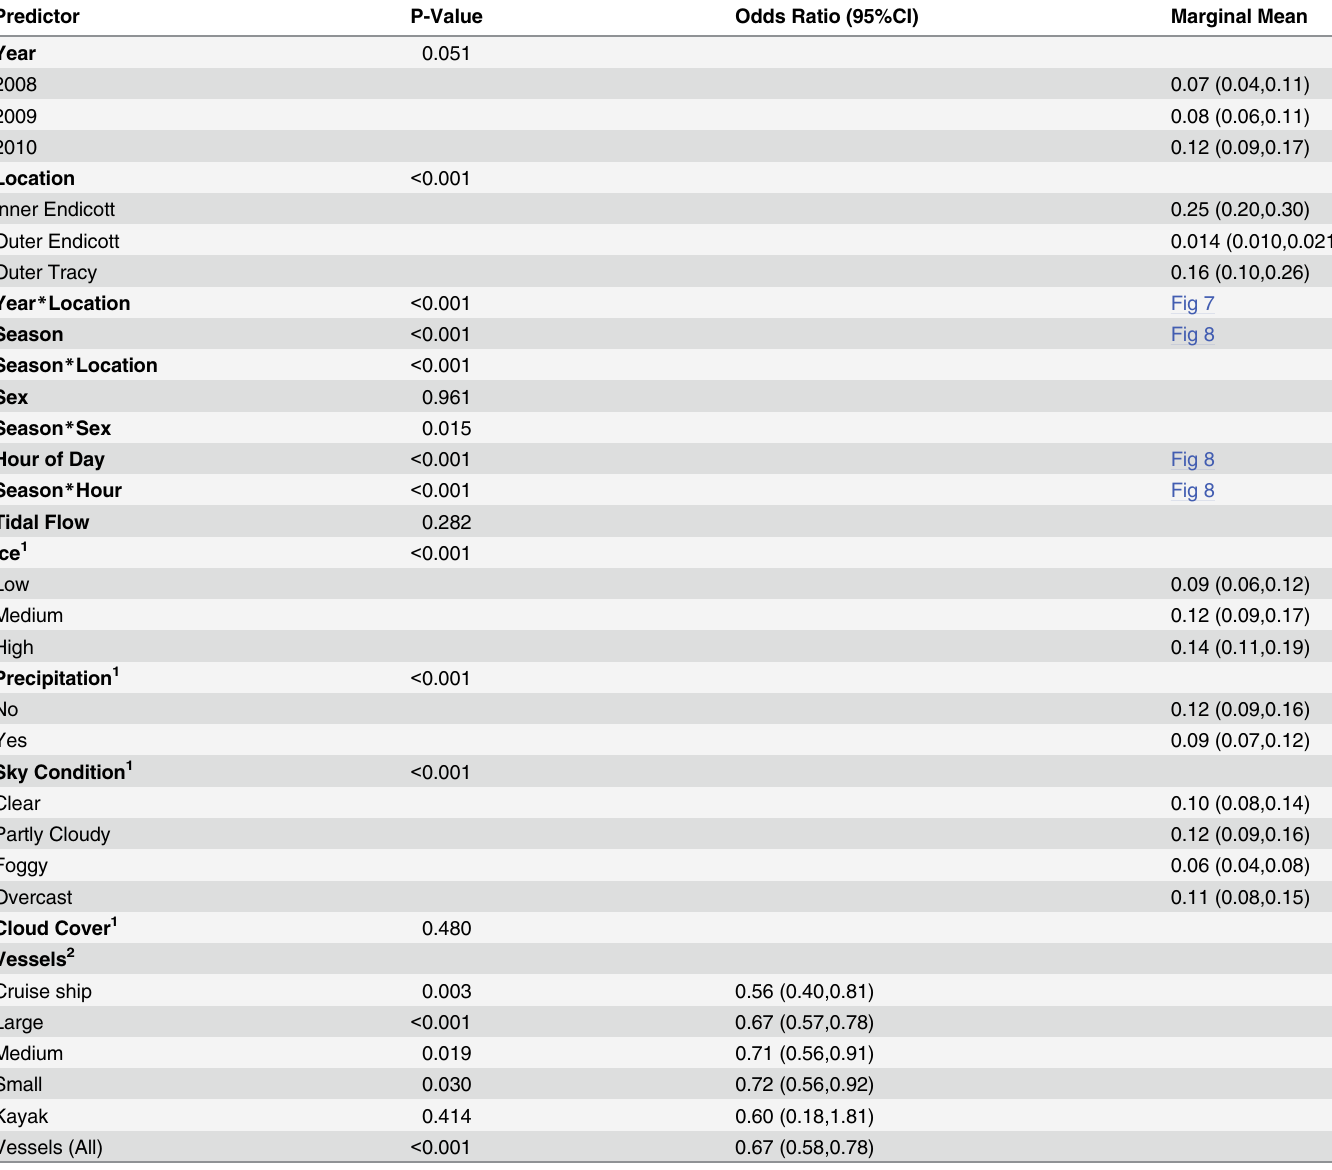
Table 4. Haul-out probability as a function of predictor